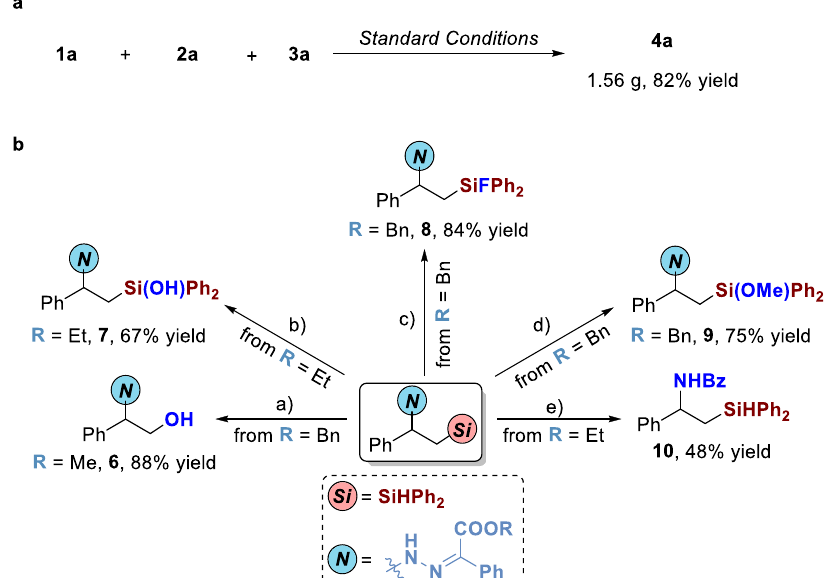
Fig. 6 Gram-scale reaction and synthetic applications. a Gram-scale reaction. b Synthetic applications. Reagents and conditions: (a) KF (4.0 equiv.), KHCO 3 (4.0 equiv.), H 2 O 2 (23.0 equiv.), MeOH/THF = 1/1, 65 o C, 12 h; (b) KHCO 3 (1.0 equiv.), H 2 O 2 (18.0 equiv.), MeOH/THF = 1/1, r.t., 12 h; (c) CuCl 2 (4.0 equiv.), CuI (18 mol%), KF (2.4 equiv.), THF, r.t., 12 h; (d) Pd/C (10 wt%), MeOH/THF = 4/1, r.t., 12 h; (e) i) SmI 2 (3.4 equiv.), MeOH/THF = 1/1, r.t., 12 h; ii) BzCl (3.0 equiv.), Et 3 N (4.0 equiv.), THF, r.t., 2 h. The details can be found in the Supplementary